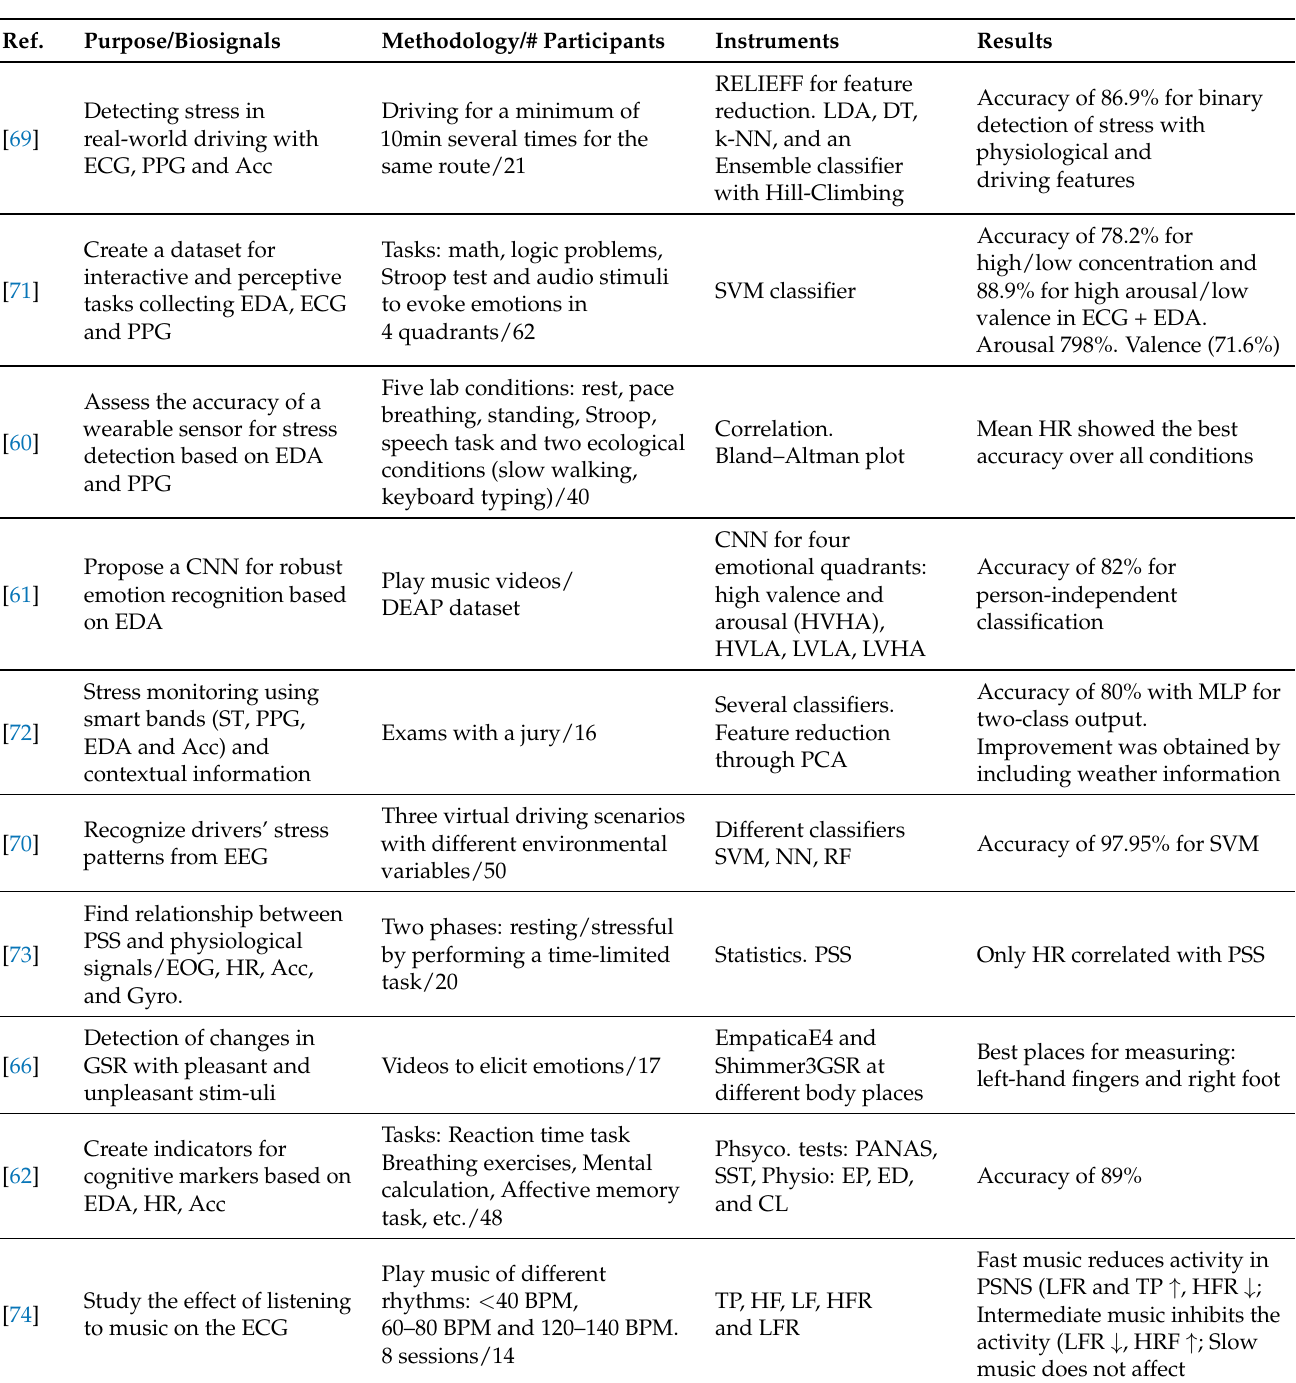
Table 3. Description of selected studies for stress detection. Some acronyms: CNN, electrocardiog- raphy (ECG), EDA, electroencephalography (EEG), electromyography (EMG), electroeculography (EOG), Eye tracking (ET) GMM, HHC, HMM, NWFE, principal component analysis (PCA),